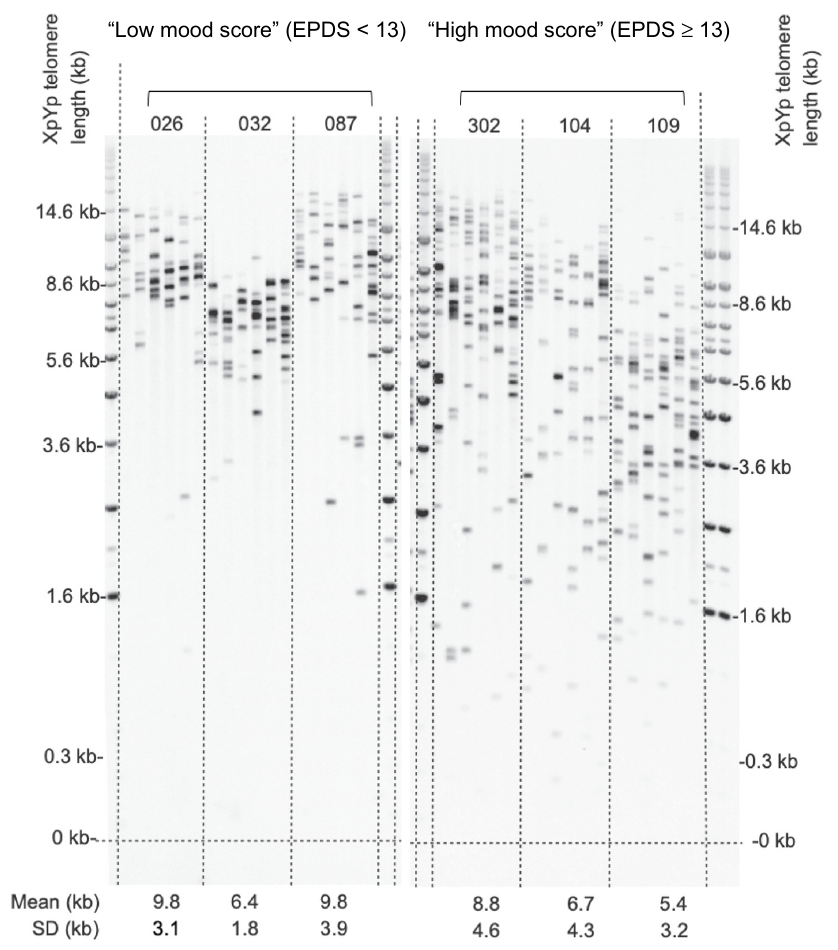
Figure 2. Representative STELA. Images of two autoradiographs are shown alongside molecular weight markers. The left panel shows STELA PCR reactions from three female placenta samples from the “low mood score” (EPDS < 13) group with 6 reactions run for each sample. The right panel shows comparable data for “high mood score” (EPDS ≥ 13) group. Mean telomere lengths ± standard deviation (SD) are given below the lanes for each sample. The coefficient of variation of all samples was <1 indicating low variance.